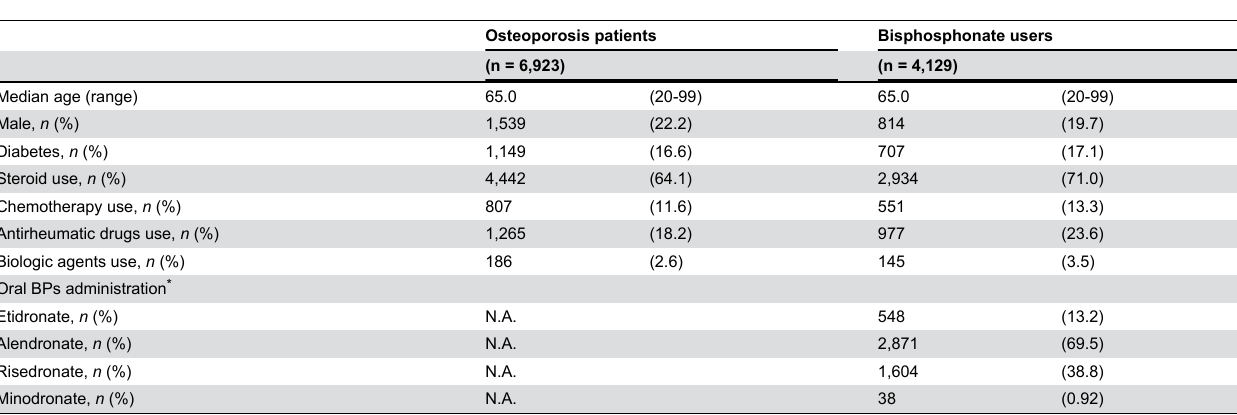
Table 1. Characteristics of all patients taking any medications for osteoporosis and the subset of oral bisphosphonate users.